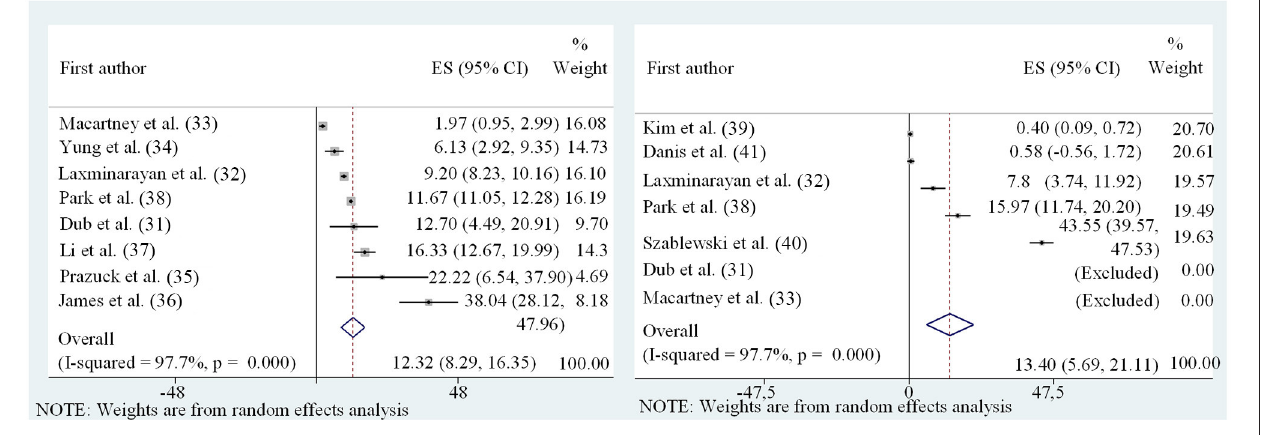
and the individual importance of these factors is